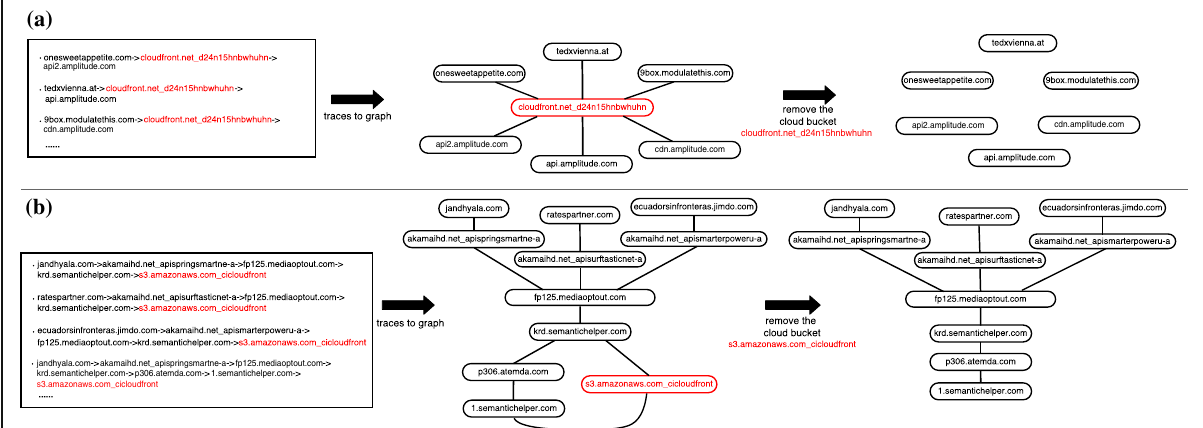
Fig. 3 Example of the redirection infrastructure leading to the le- gitimate bucket cloudf ront.net d 24 n 15 hnbwhuhn ( a ) and the Bar s 3 .amazonaws.com cicloudf ront ( b ), which are in RED